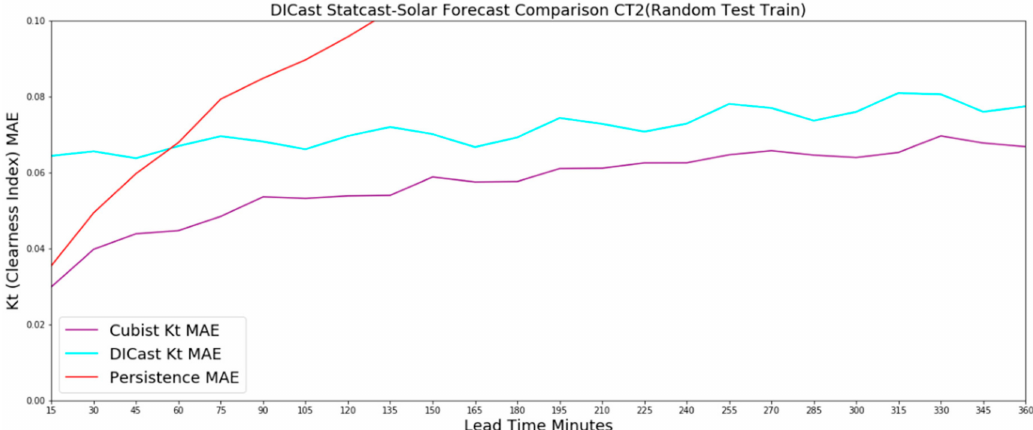
Figure 11. Results for the Cubist model configurations compared to the DICast forecasts of Kt and smart persistence. The Cubist-based method performs best for all time periods from 15 min to 360 min compared to either DICast or smart persistence.